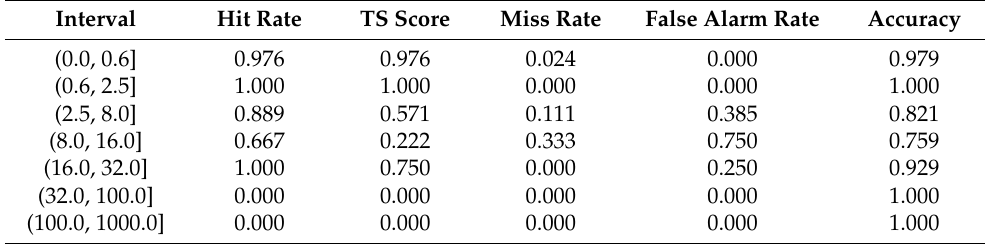
Table 2. Assessment of quality control results of the scoring method for each precipitation inter- val.